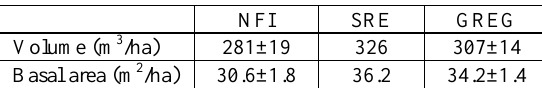
Table 3. Mean volume and basal area estimates for the Valais